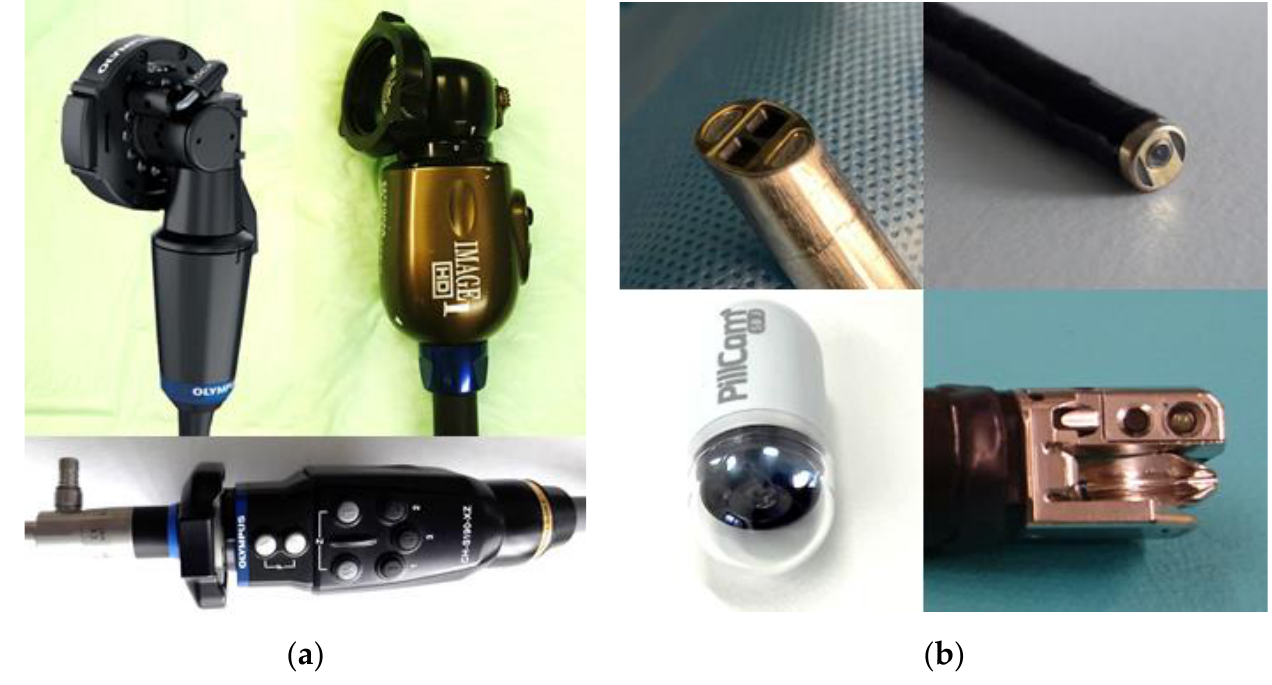
Figure 4. ( a ) Camera heads with C-mount connector, upper row: OLYMPUS pendulum camera, KARL STORZ H3P CCD camera, OLYMPUS CCD autoclavable camera ( b ) integrated cameras, up- per row: Intuitive Da Vinci stereo camera, OLYMPUS rhinolaryngoscope camera, lower row: Med- tronic PillCam with LED lights, Fujifilm duodenoscope camera.